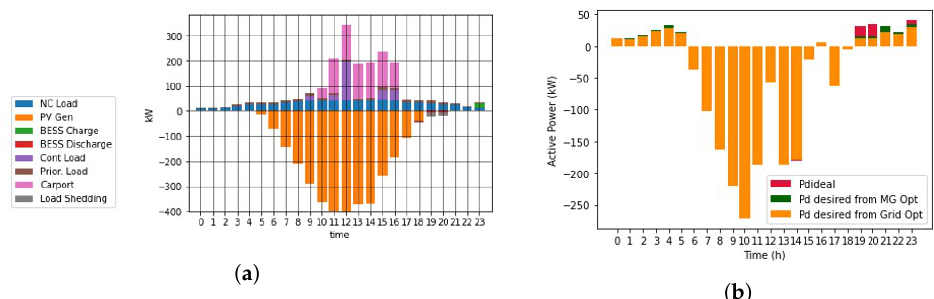
Figure 12. Proposed dispatch for the microgrid in the third iteration of the hierarchical model. ( a ) Dispatch of the microgrid. ( b ) Dispatch from the point of view of the active network.